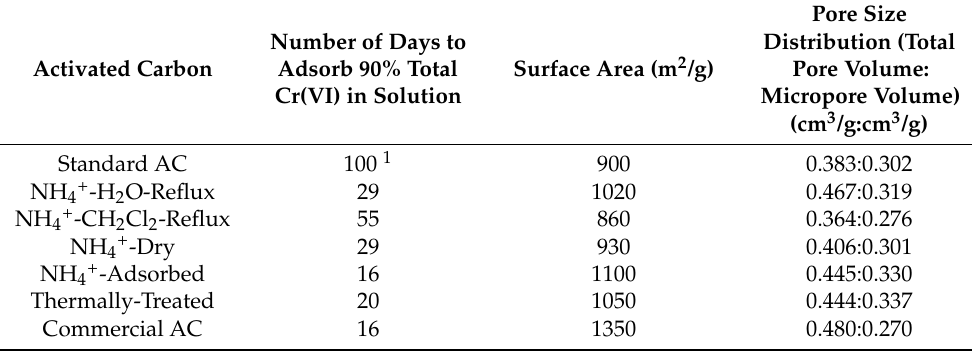
Table 3. The number of days required for various activated carbons to effectively remove chromium (VI) from solution while comparing their surface area and pore size distributions.